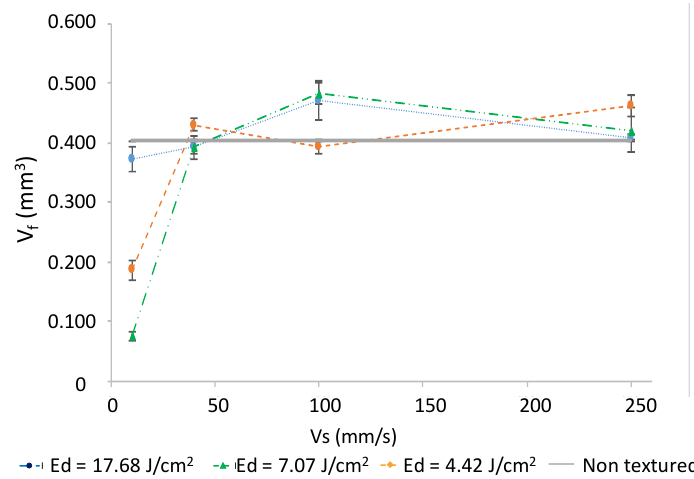
Figure 14. Worn material behavior as a function of V s .